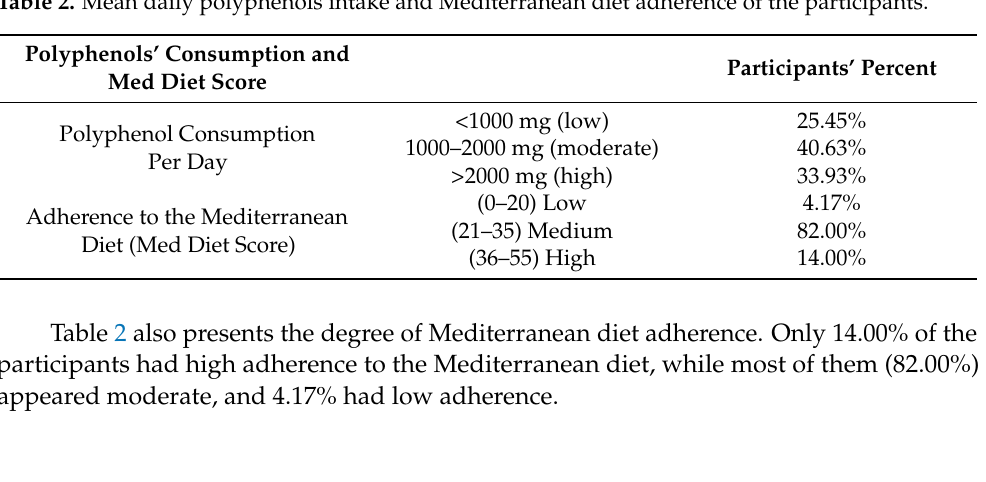
Table 2. Mean daily polyphenols intake and Mediterranean diet adherence of the